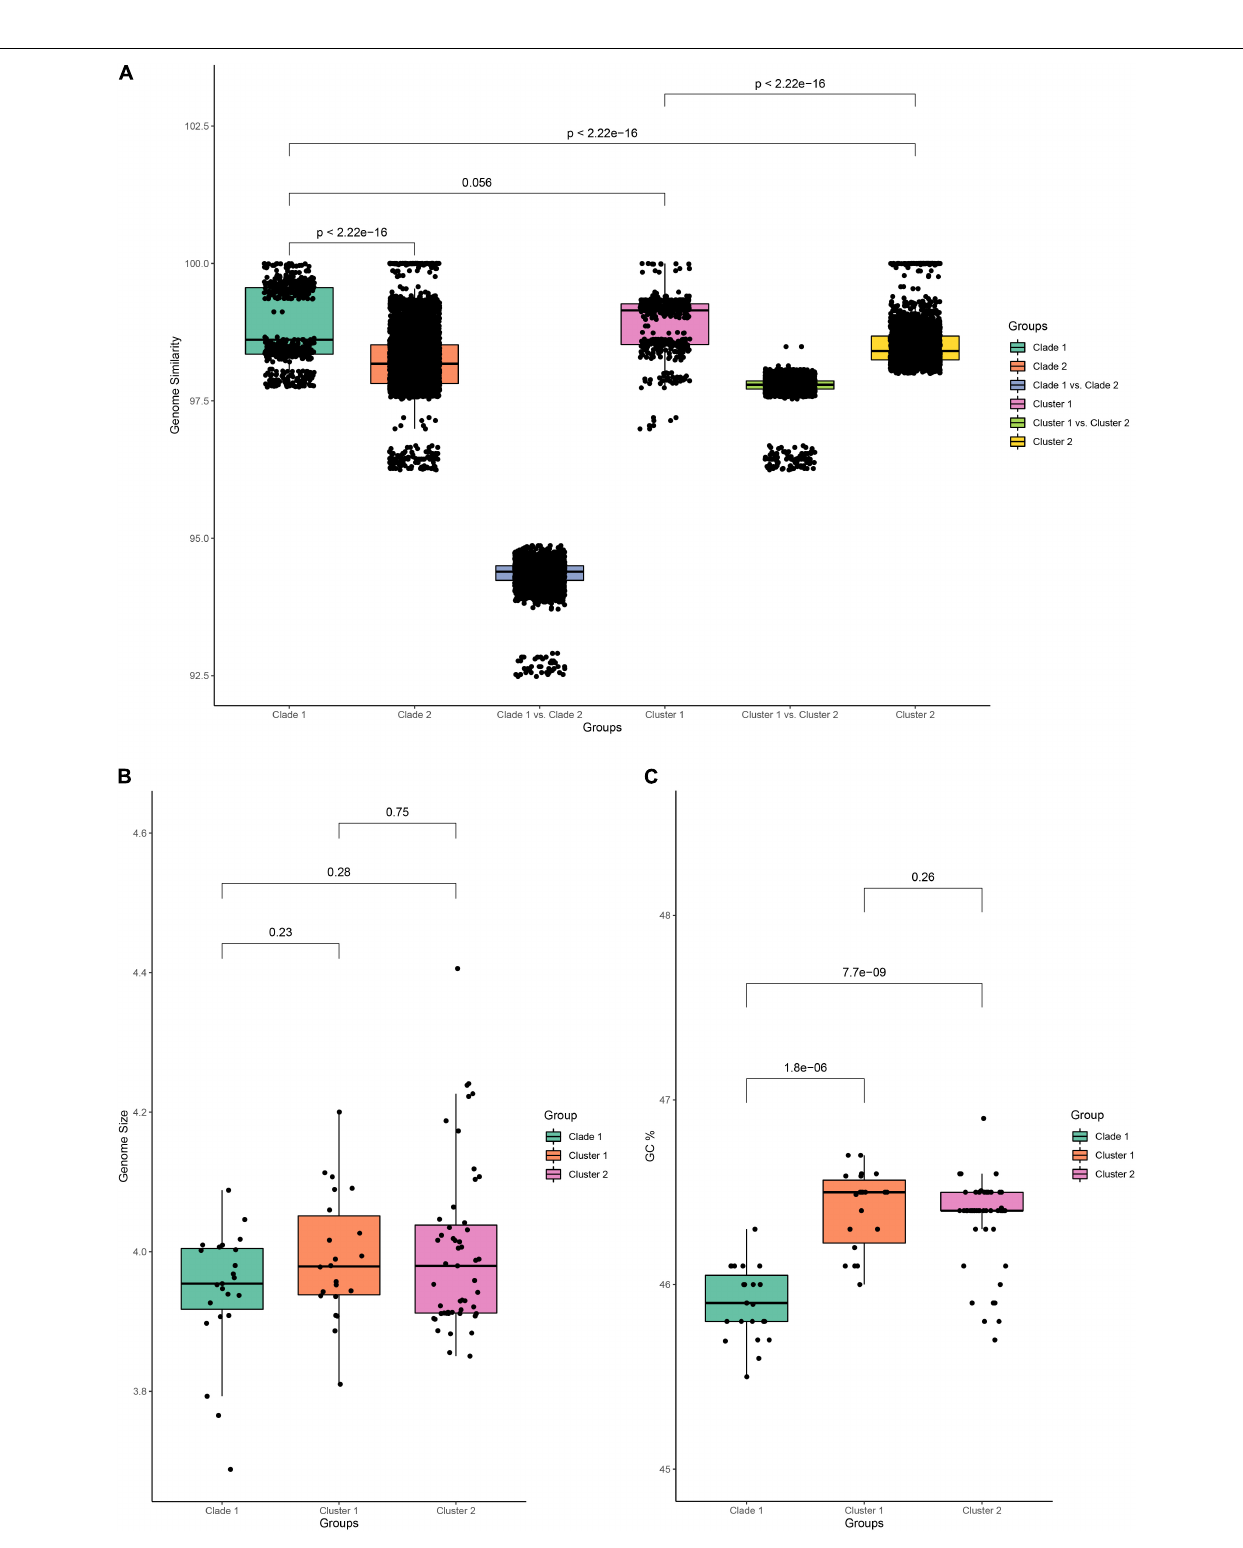
Frontiers in Genetics |